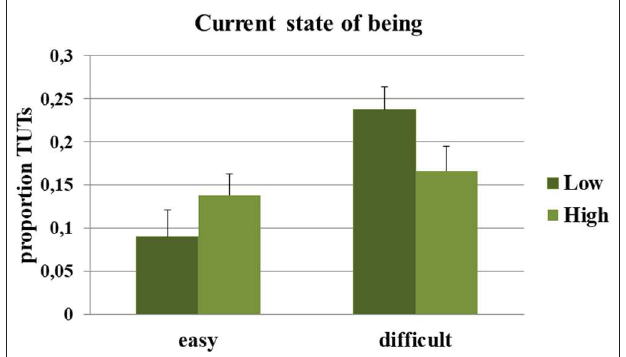
FIGURE 3 | Mean proportion of TUTs (current state of being) depending on the factors low and high WMC and the difficulty of the text.